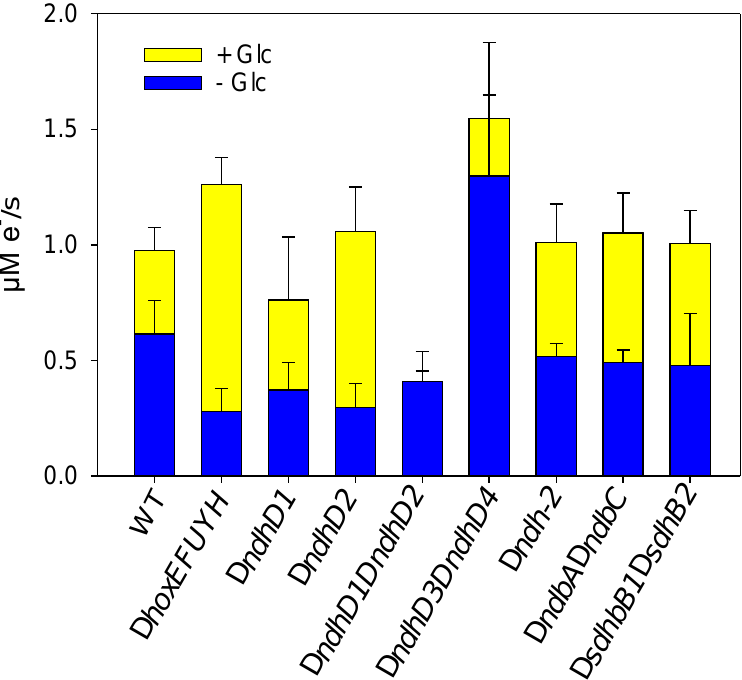
Figure 7. Electron flow with and without glucose in the presence of DCMU for the different deletion strains. Cell suspensions were diluted to OD 750 = 5.7 and were illuminated with 222 µE/m 2 /s for 3 min before DIRK measurements were started. After the first round of these measurements 10 mM glucose was added and after 1.5 min another set of DIRK measurements was started. The measurements were conducted at least in triplicates. Their standard deviation is indicated.